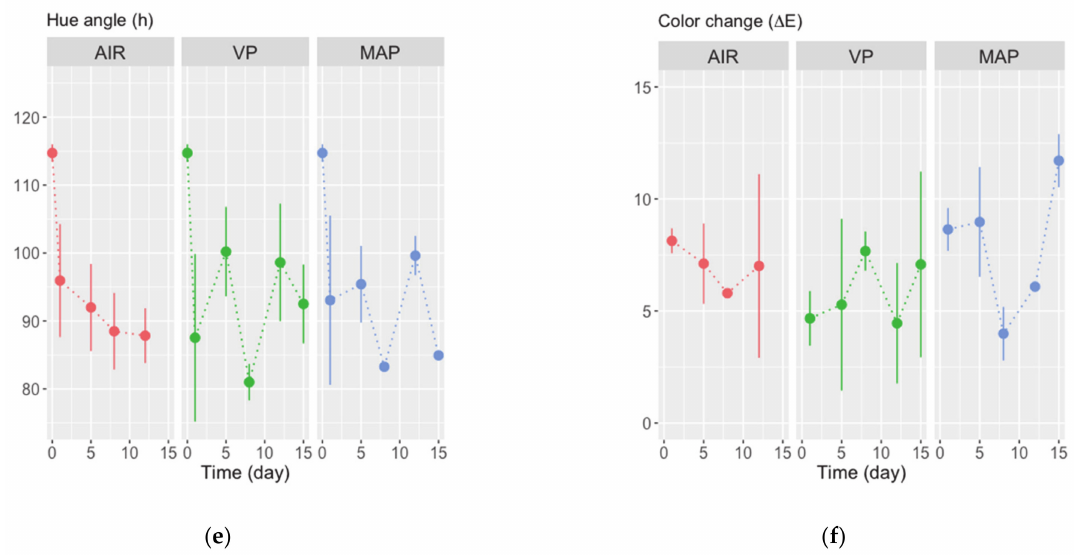
Figure 1. Changes in color parameters, ( a ) L*, ( b ) a*, ( c ) b*, ( d ) chroma, ( e ) hue angle, and ( f ) ∆ E, measured in fillets of triggerfish packed in air (AIR), vacuum (VP), and modified atmosphere (MAP) stored refrigerated for 15 days. Values are means of n = 2 fillets and whiskers represent the standard-error (SE). Table 2. Results of ANOVA per physicochemical quality parameter considering factors time (0, 1, 5, 10, and 15 days) and packaging (AIR, VP, and